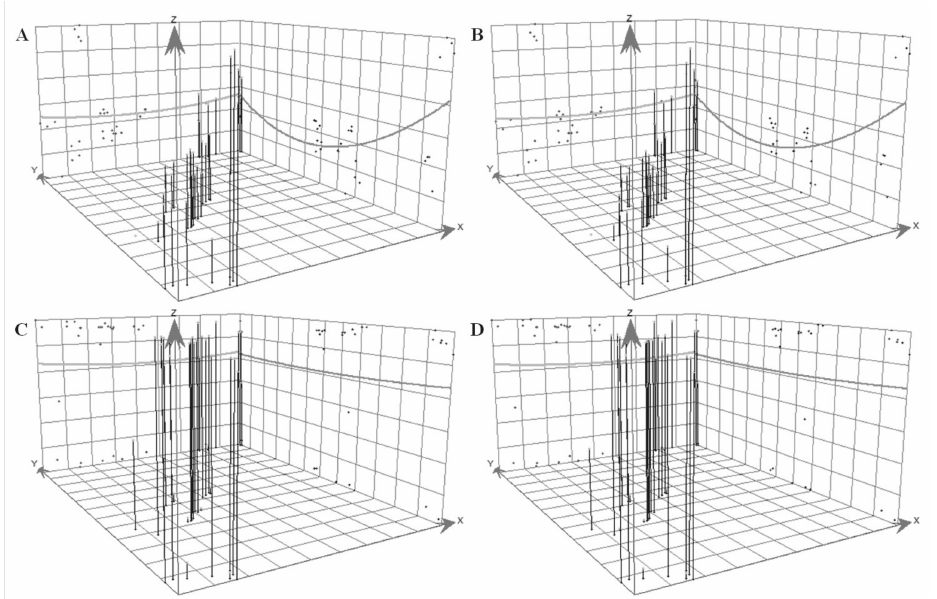
Figure 7. Comparison between ecological niche widths and overlaps on the level of giant panda habitat under the different age dominated natural resource utilization. Note: ( A ) Trend of ecological niche widths in OAG. ( B ) Trend of ecological niche widths in YAG. ( C ) Trend of ecological niche overlaps in OAG. ( D ) Trend of ecological niche overlaps in